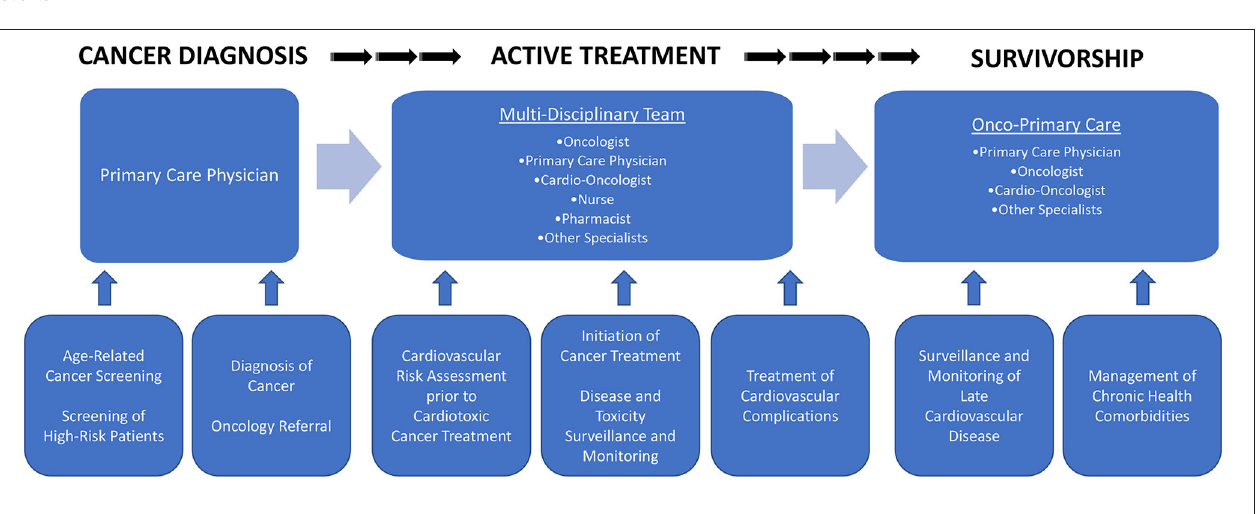
( Table 4 ). These include potential drug-drug interactions between dyslipidemia medications and chemotherapy, patients with liver disease, and patients that suffer adverse reactions from dyslipidemia